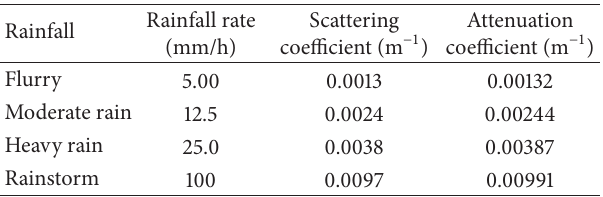
Table 1: Attenuation coefficients of different rainfall